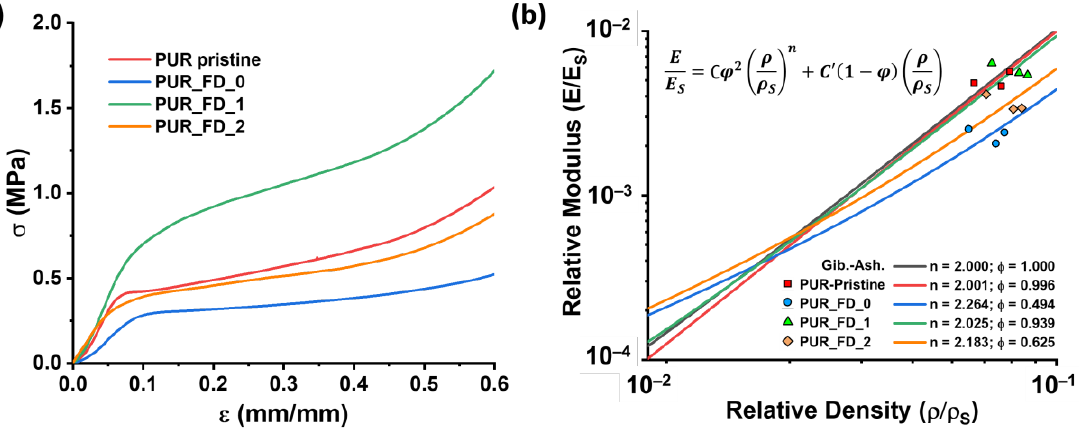
Figure 8. ( a ) Compressive stress vs. strain of the selected foams and ( b ) the resulting modified Gibson–Ashby model applied to the selected foams. Table 4. Mechanical properties upon compression tests.